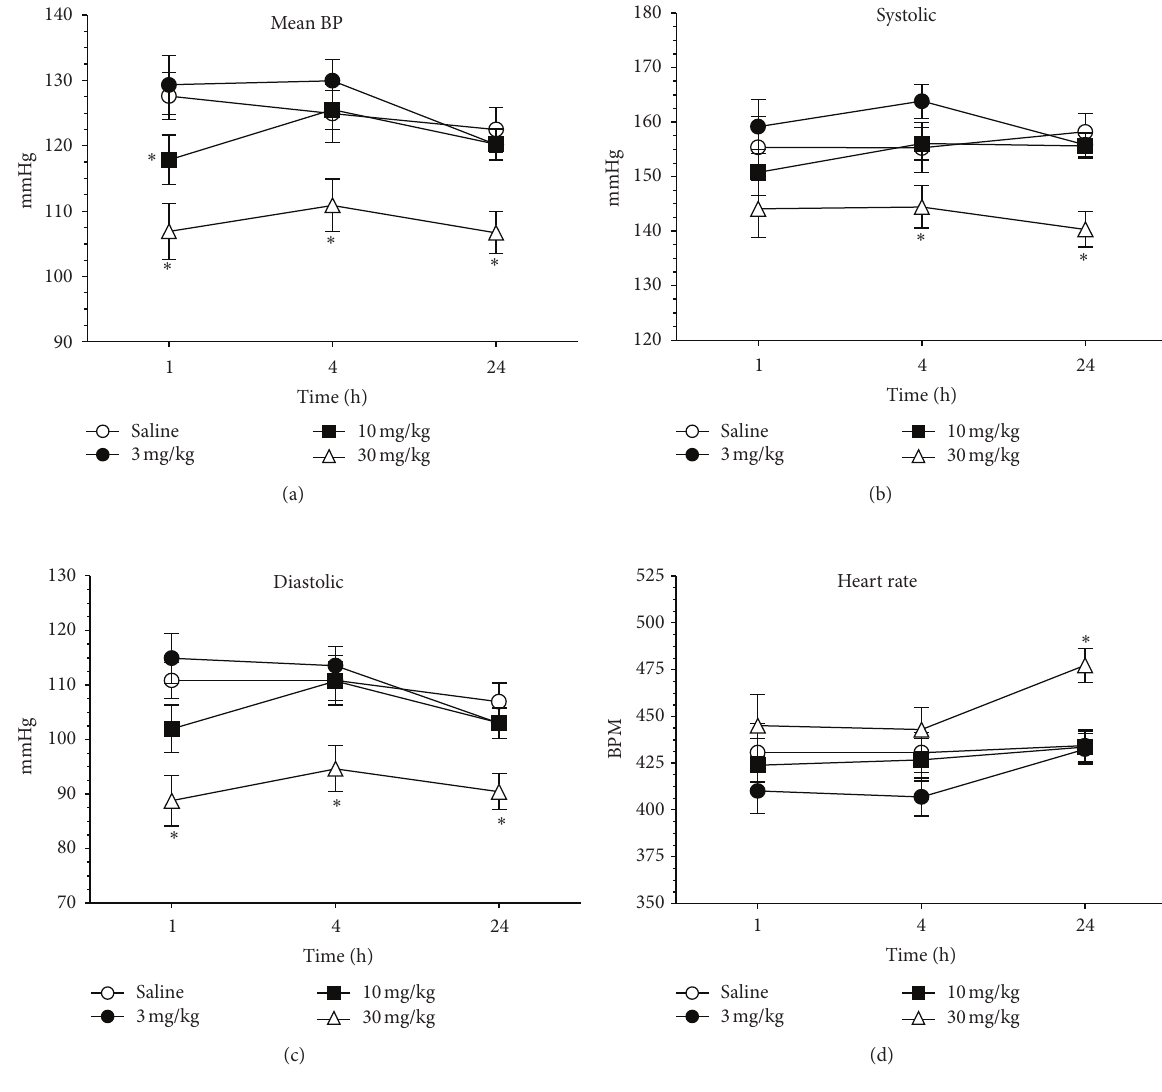
F 2: Dose response of hemodynamic measurements of acute nisoxetine or saline. Animals underwent a 24h food deprivation prior to injections and refeeding. All animals were fed and maintained on standard chow (13 with a week washout between doses and tail-cuff volume pressure recording were performed at 1h, 4h, and 24h. (a). Mean blood pressure (b). Systolic blood pressure (c). Diastolic blood pressure (d). Heart rate. Asterisks indicate difference from saline ( time